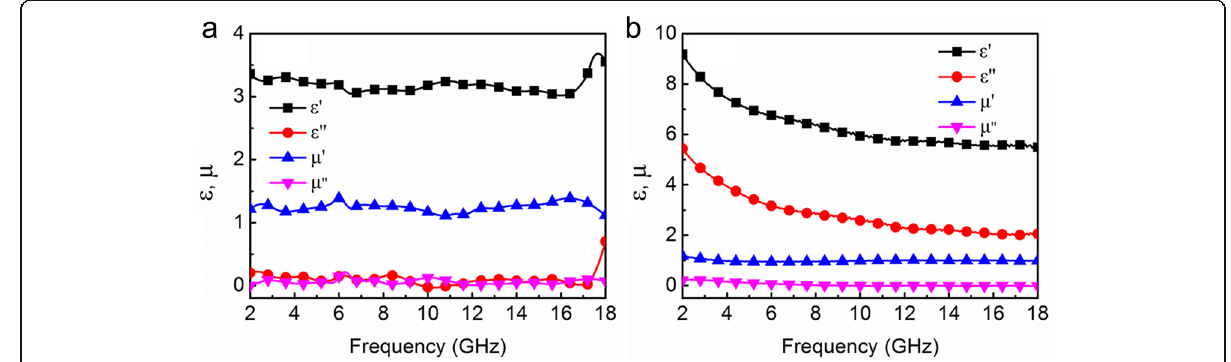
Fig. 7 Frequency dependence of real and imaginary parts of complex permittivity and permeability of a CoFe 2 O 4 and b